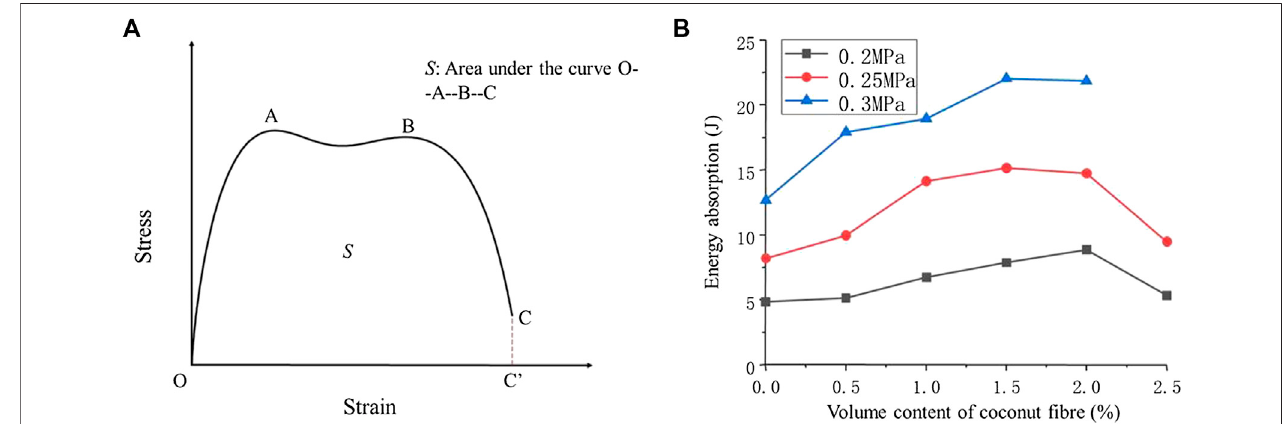
FIGURE 12 | Energy absorption capability (A) Schematic (B) Energy absorptions of